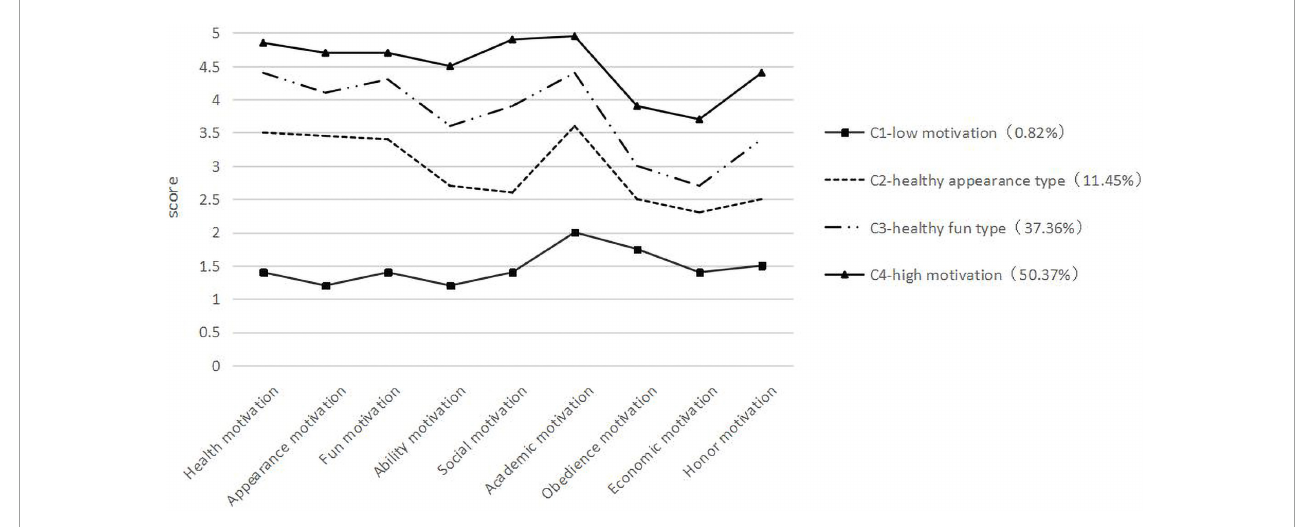
FIGURE1 College students’ scores in nine categories of behavior